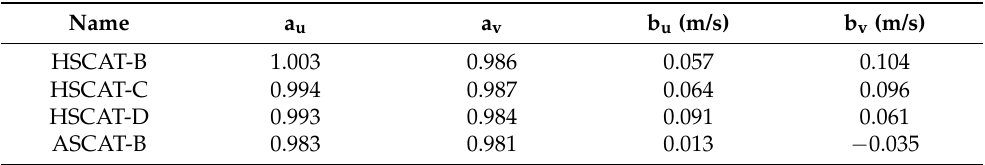
Table 6. Calibration coefficients for u and v wind components from the ETC of the scatterometer with buoy and ECMWF